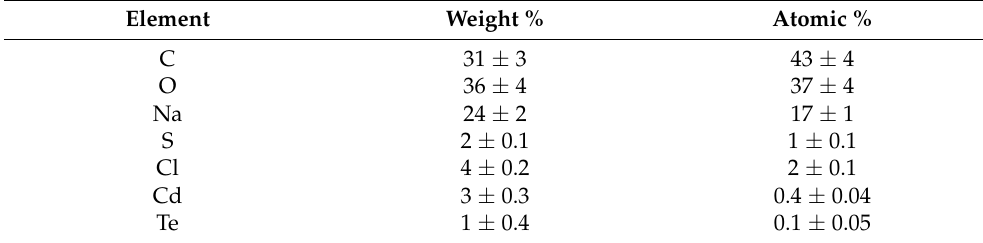
Table 2. EDS elemental composition of the TMPyP/GSH-CdTeQD/GOx system deposited on carbon. Element Weight % Atomic